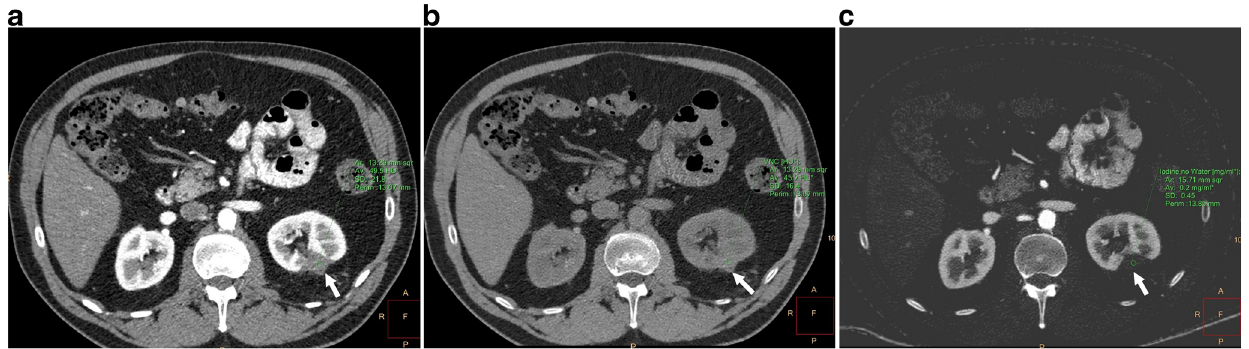
Fig. 10 Lesion characterisation. ( a ) 120-kVp routine-diagnostic (conventional) CT image through the upper abdomen shows a well- defined hypoattenuating lesion in the left kidney ( arrow ), which has a meanattenuationof49.5HU, whichistoo high fora simple cyst. Thiscan either be a complicated cyst or enhancing solid lesion. ( b ) VNC reconstruction at the same level shows that the attenuation of the lesion